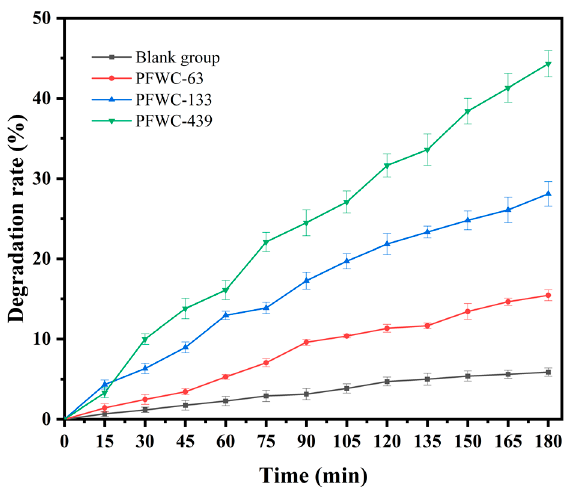
Figure 6. The photocatalytic degradation rates of gaseous toluene on the PFWC under ultraviolet